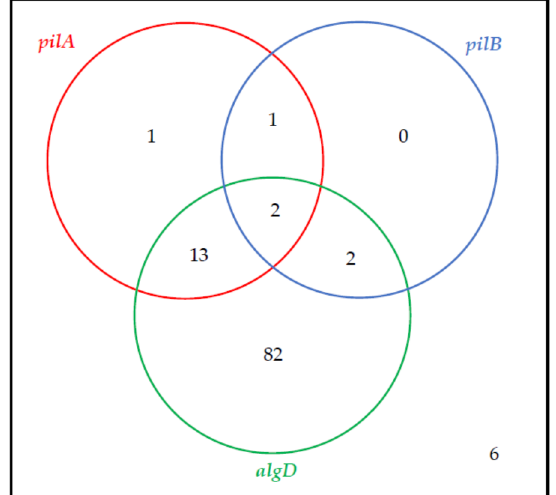
Figure 1. The co-existence of biofilm synthesis-associated genes (Venn diagram) amongst the tested strains ( n = 107).